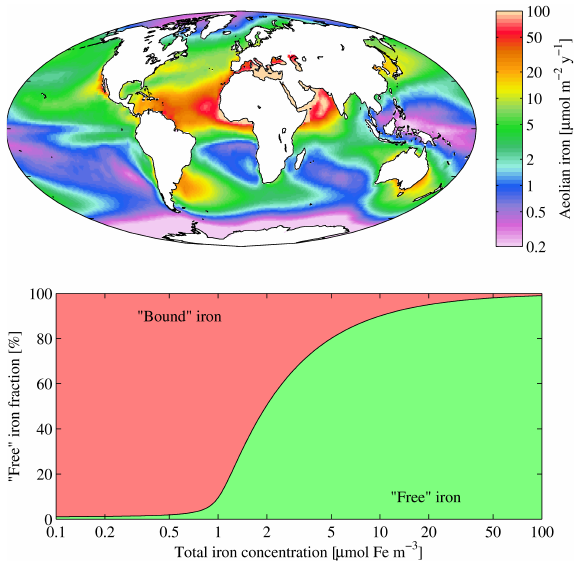
Fig. 3. The top panel shows mean annual aeolian iron input to the Fig.2. The top panelshowsmeanannual aeolianironinputtotheocean( i.e. thequantityofironthatdissolvesinto seawater from depositeddust). The input isshownona logarithmicscale inunits of µ mol m − 2 y − 1 , andintegrated ocean (i.e. the quantity of iron that dissolves into seawater from de- inputis2.564GmolFey − 1 . The bottom panelshowsthefractionationoftotalironbetween“free”andligand–bound formsacrossalogarithmicrangeoftotalironconcentrations. posited dust). The input is shown on a logarithmic scale in units of µmolm − 2 yr − 1 , and integrated input is 2.564GmolFeyr − 1 . The bottom panel shows the fractionation of total iron between “free” and ligand-bound forms across a logarithmic range of total iron con-